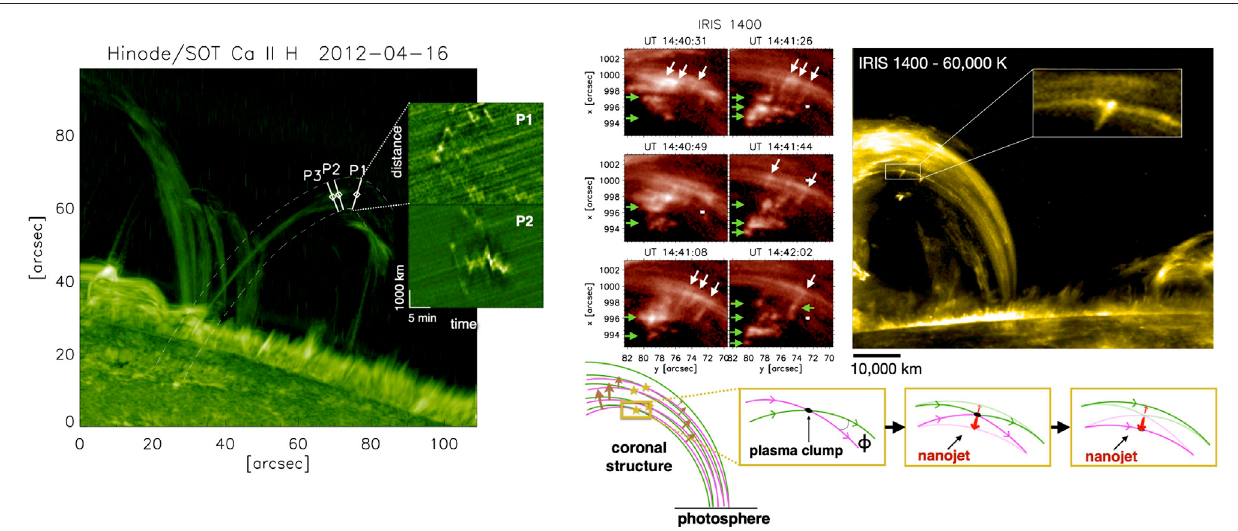
FIGURE 19 | Coronal rain as a tracer of coronal heating mechanisms. Left: a Hinode /SOT observation in the Ca II H line reveals several loops with coronal rain, reported by Verwichte et al. (2017) (Figures 4 and 5 of that paper, reproduced with permission © ESO). The 2-panel inset shows the time-distance diagram across transverse cuts P1 and P2 near the apex of a loop. Transverse MHD oscillations can be clearly seen. Right: Nanojets observed in a hybrid prominence/coronal rain complex with IRIS /SJI 1400, reported by Antolin et al. (2022) (adapted from Figures 1, 2 and 6 of that paper). The left 6-panels show a time sequence in which a nanojet cluster can be seen (white arrows), some ejecting plasmoids (green arrows). The bottom panel shows a sketch of the interpretation. Component magnetic reconnectionleadstolocalisedheatingandtransverseadvectionofreconnected fi eldlinesdrivenbymagnetictension,resultinginthenanojetfeature.Seetherespective papers for further